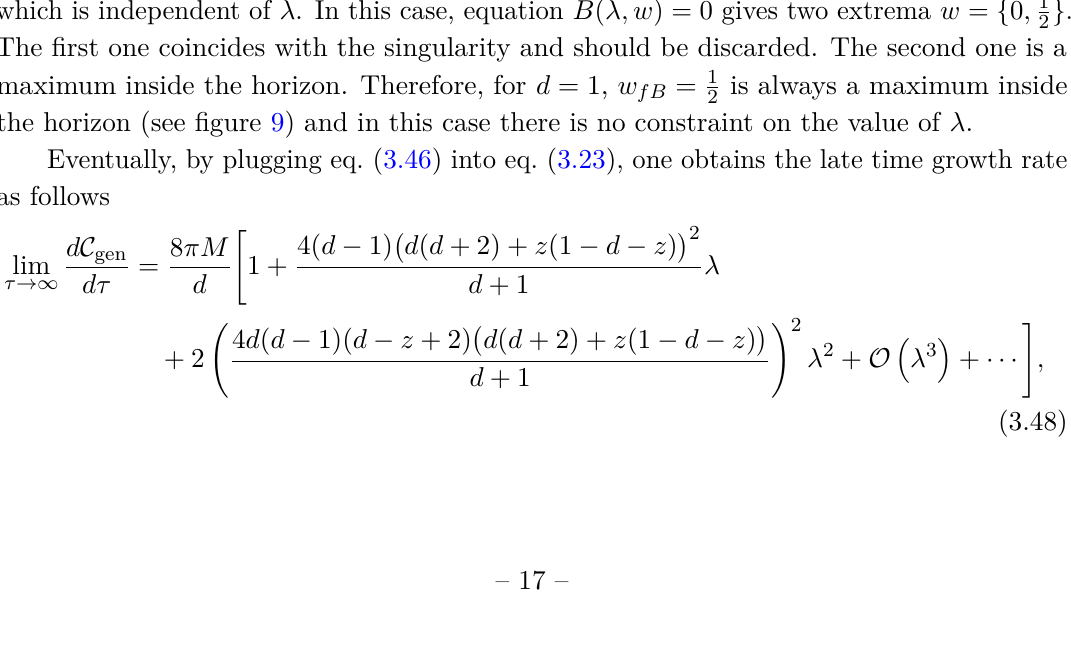
Figure 8 . The effective potential For all values of z , there is a maximum w given in table